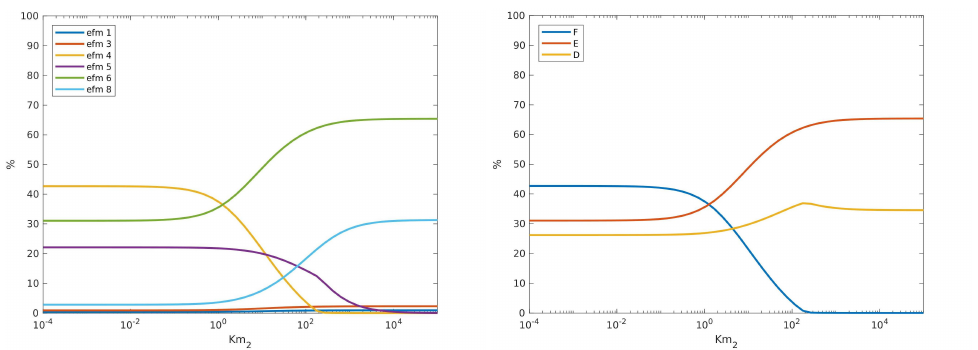
Figure 6. Effects of parameter Km 2 on the decomposition into elementary flux modes (EFMs) of flux distributions of system (9) at equilibrium. Left: Proportion of each EFM. Right: The EFMs are grouped according to the metabolite they